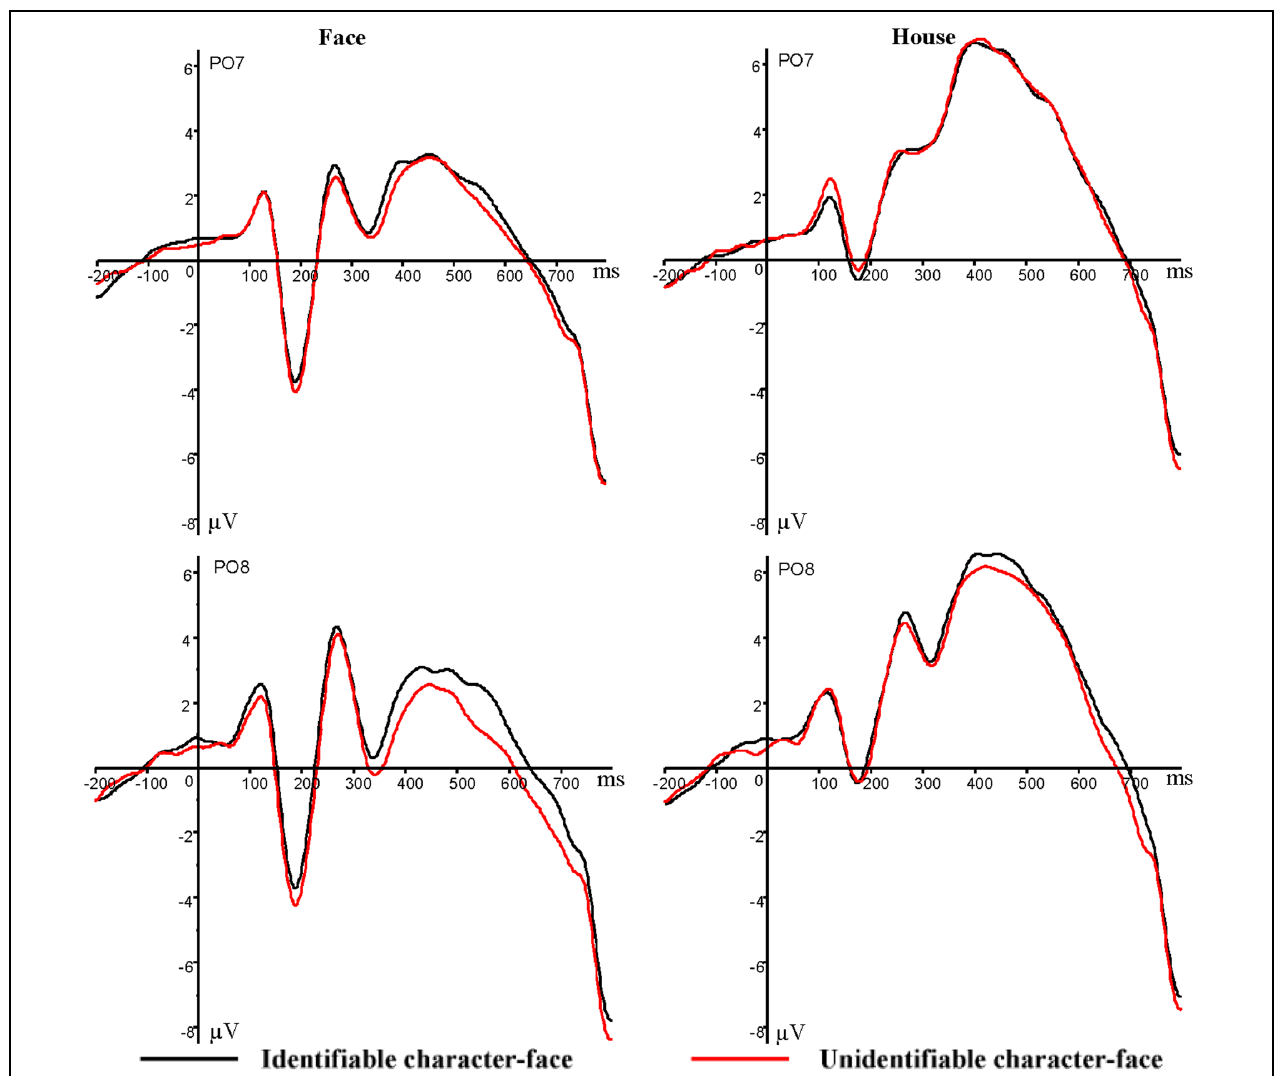
FIGURE 4 | Grand average ERP waveforms for faces/houses when they were simultaneously viewed with recognizable character (black lines) and when they were simultaneously viewed with unrecognizable character (red lines) recorded at PO7 and PO8 electrode sites.